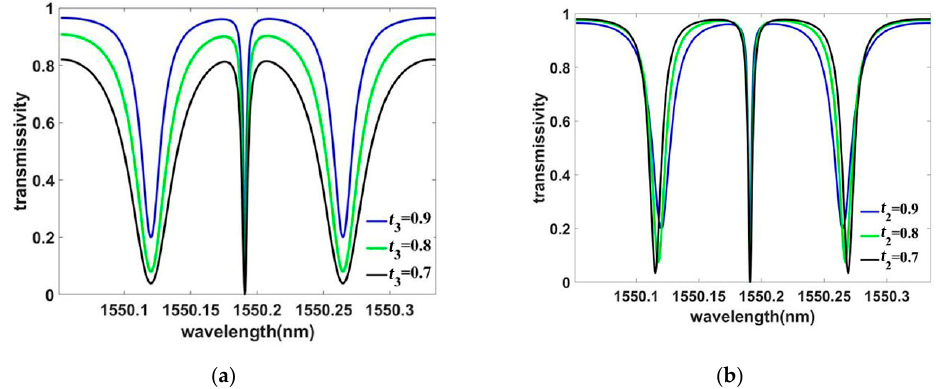
Figure 9. ( a ) The transmissivity of the double ring resonator at different wavelengths and the transmission coefficient ( t 3 ) and ( b ) the transmissivity of the double ring resonator at different wavelengths and the transmission coefficient ( t 2 ). Both are calculated at A 1 = A 2 = 0.99.